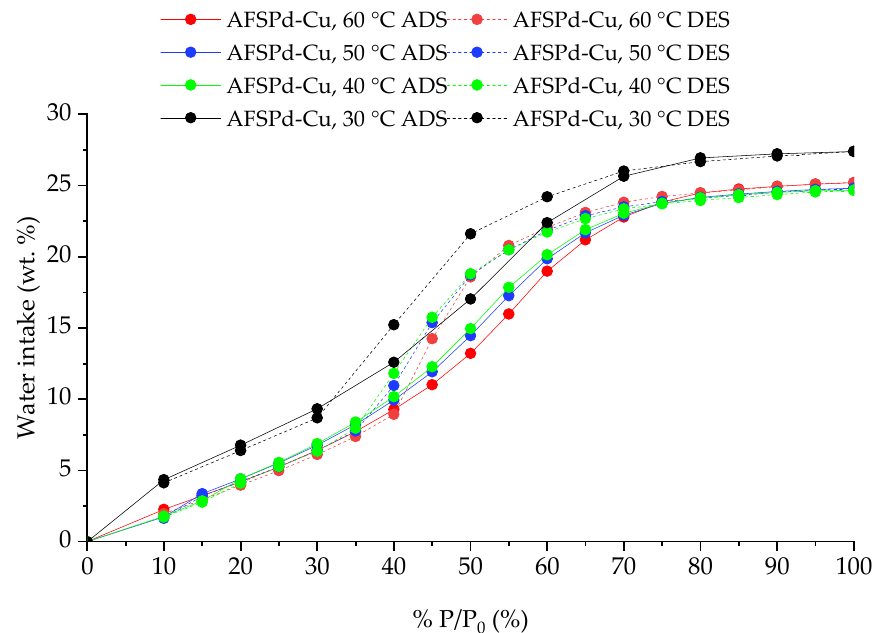
Figure 7. Adsorption and desorption isotherms for the AFSPd-Cu sample, at 30, 40, 50, and 60 °C .